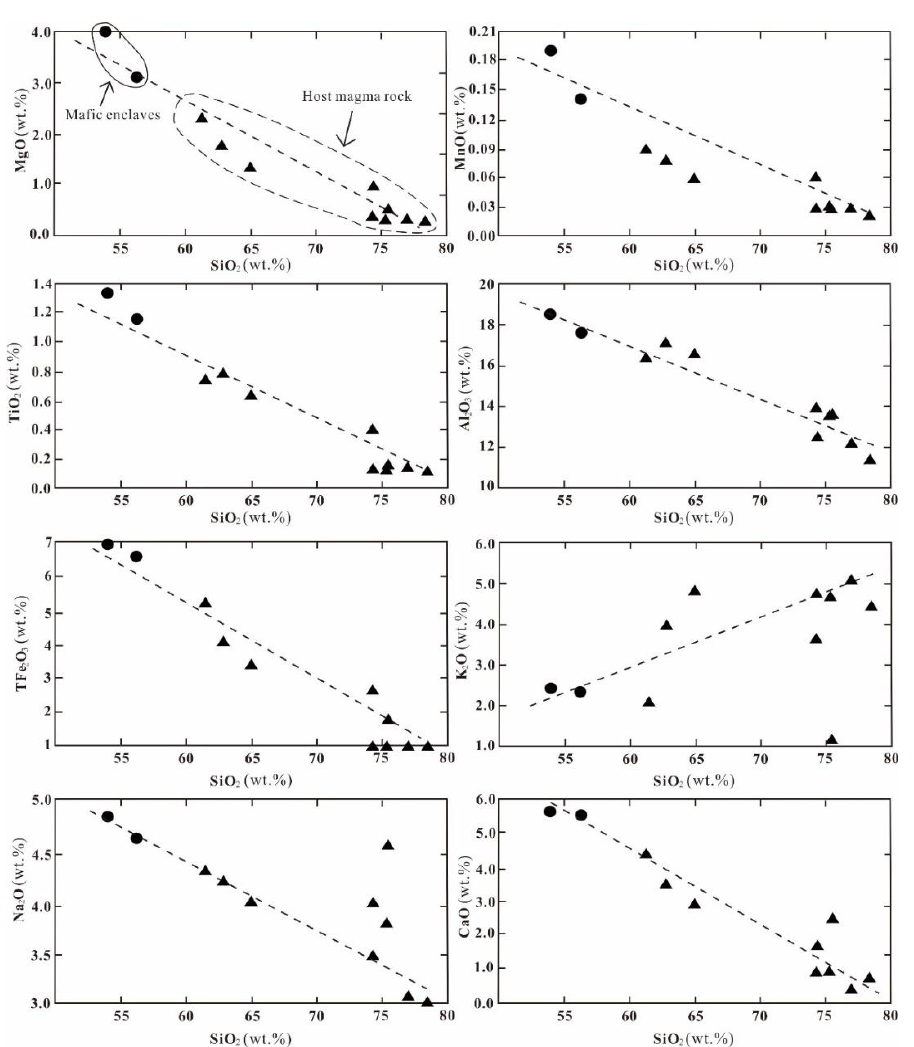
Figure 6. Harker diagrams showing the whole rock compositions of the mafic enclaves and the Qingshanbao host rock.